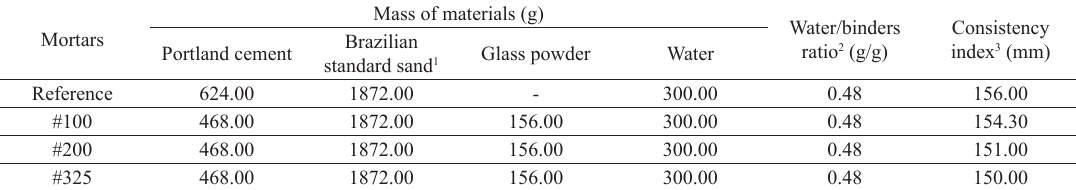
Table 2. Mix proportions of materials in the mortar used for molding the specimens to determine the performance index with the Portland cement.